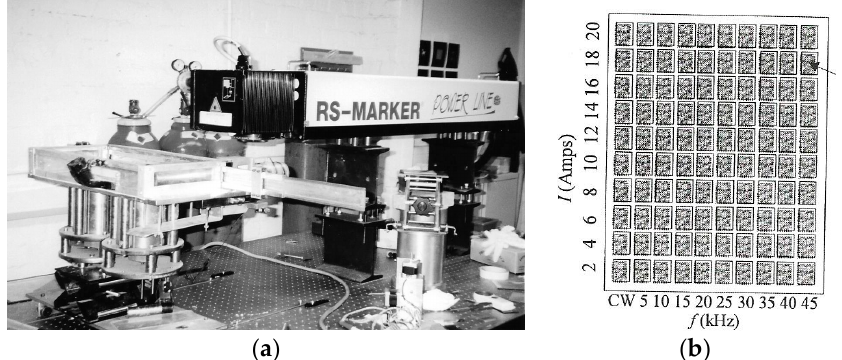
area. The focal length of the imaging lens was 112 mm, giving a minimum spot size of 50 µ m. The experimental apparatus is shown in Figure 2a.